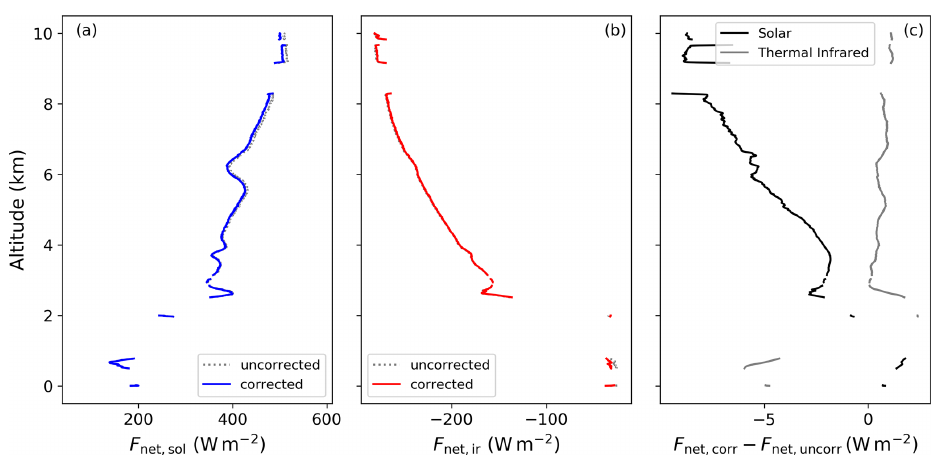
Figure 8. Vertical profiles of the solar (a) and thermal–infrared (b) net irradiance based on the thermal-corrected measurements. The gray dotted lines indicate the corresponding profiles prior to the application of the dynamic thermal offset correction. Panel (c) illustrates the difference between the corrected and uncorrected F net for the solar and the thermal–infrared ranges, respectively.